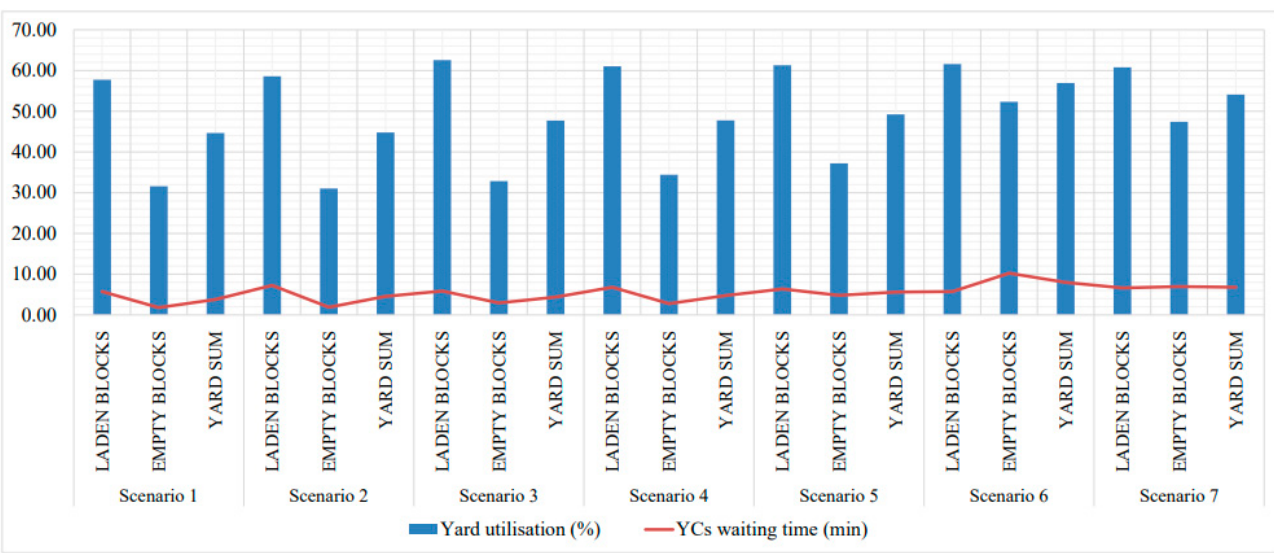
Figure 5. Graphical view of the berth results.